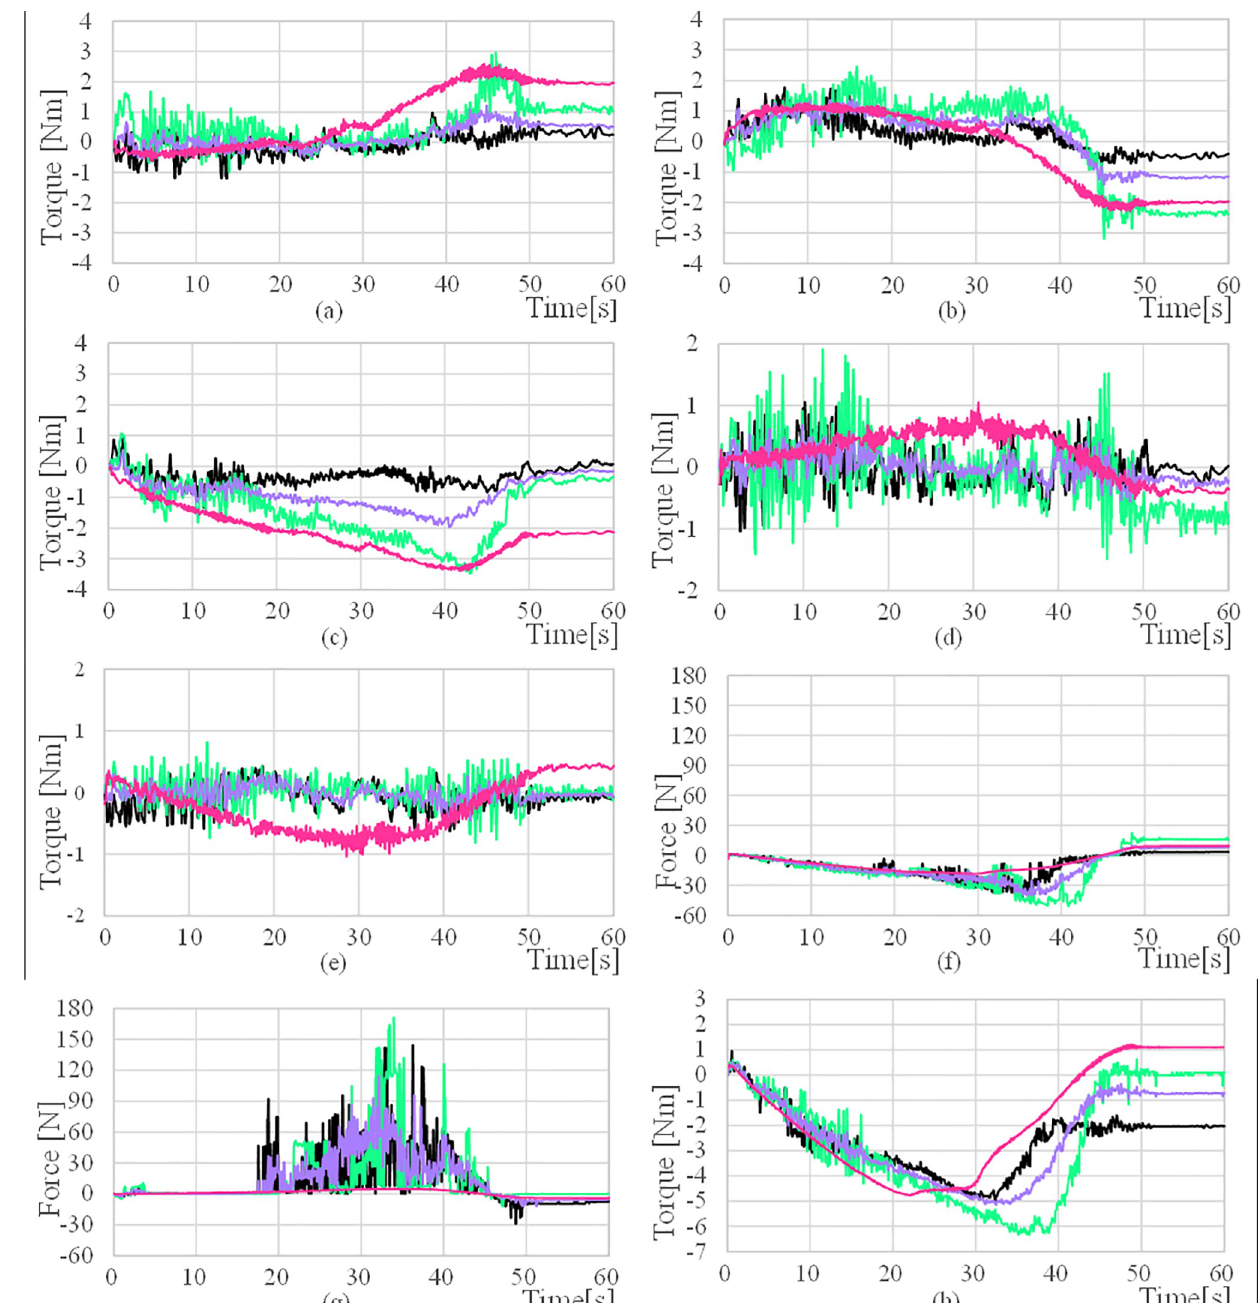
Fig 12. Manipulator joint torques and AURORA thruster force (a) τ W1 (b) τ W2 , (c) τ W3 (d) τ C1 (e) τ C2 (f) F x (g) F y (h) τ ψ .